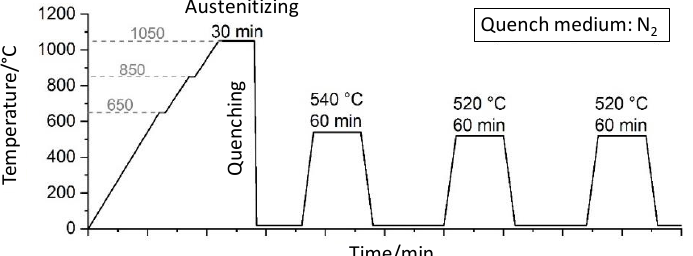
Figure 3. Schematic illustration of the conducted heat treatment. The austenitizing was performed at 1050°C for 30min with small holding steps at 650°C and 850°C. After quenching with N 2 to room temperature, three tempering stages followed to obtain the aspired microstructure.